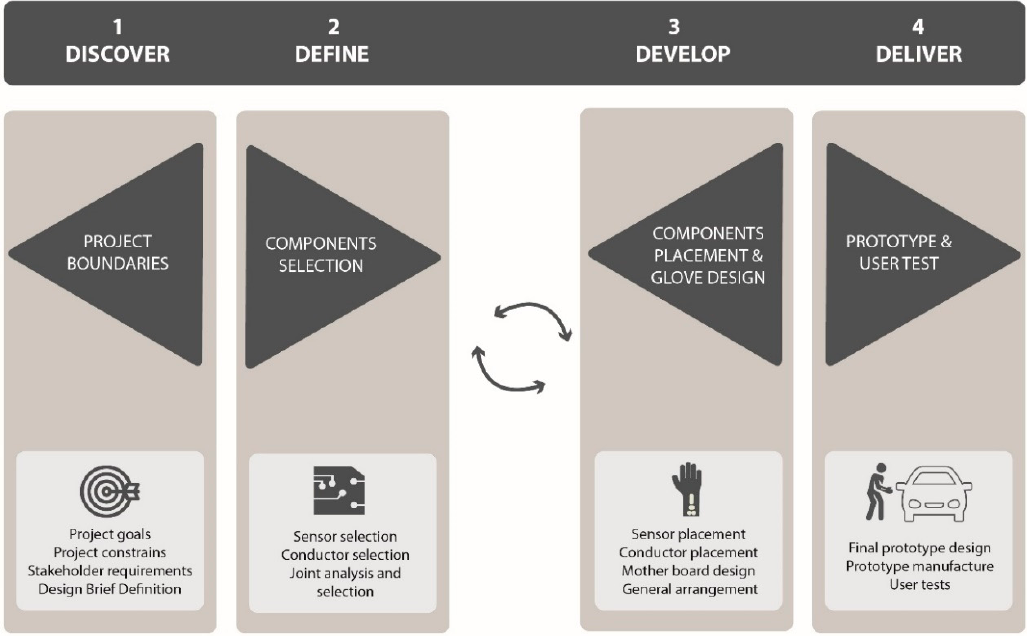
Figure 1. Smart glove design process based on the double diagram model (Adapted from Design Council).